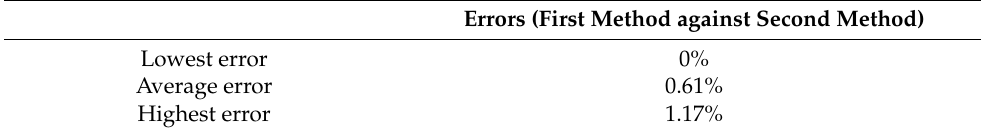
Table 4. Errors of the first method obtained from 100 million experiments.